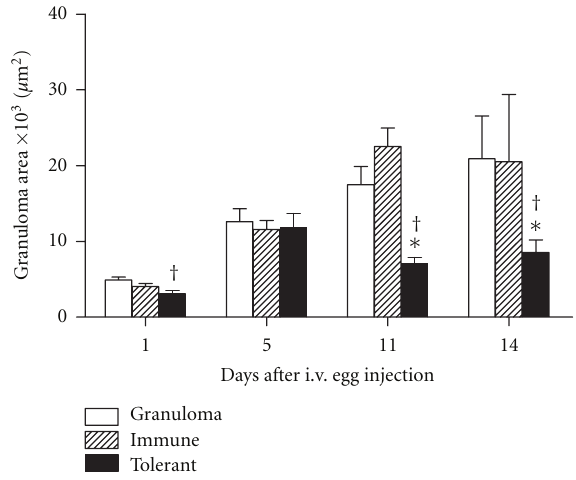
Figure 3: Re-exposure of orally tolerant animals to the toler- ated antigen block enlargement of granuloma area. The area of granulomas at days 1, 5, 11 and 14 after i.v. injection of eggs in nonimmunized mice (granuloma group, open bars), OVA immune controls (hatched bars), and OVA-orally tolerant (black bars). Data represent mean ± SEM (five mice/group). ∗ P ≤ 0 . 05 tolerant versus immune and † P ≤ 0 . 05 tolerant versus